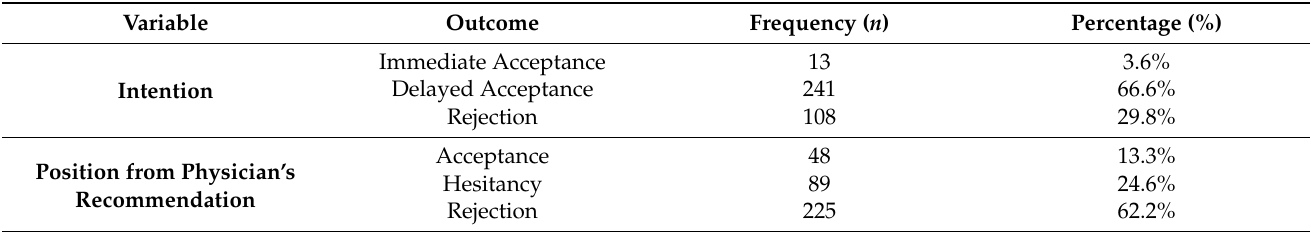
Table 4. COVID-19 vaccine-related attitudes of pregnant and lactating women (PLW), University Hospital Brno, August –October 2021 ( n =